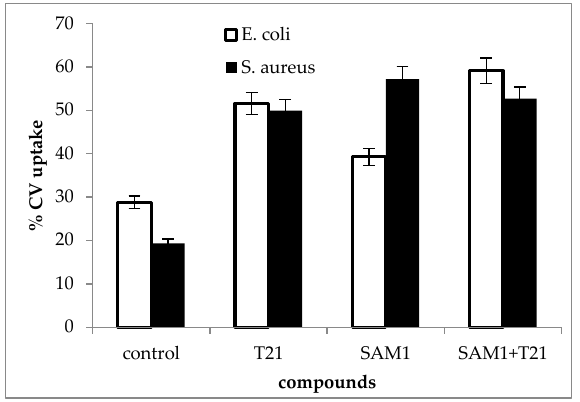
Figure 8. Crystal violet uptake in S. aureus ATCC 33952 and E. coli ATCC 11229 cultures after treatment with T21, SAM1, and SAM1 + T21 (concentration of compounds and combinations: T21 0.5%; SAM1 1MIC; SAM1 1MIC + T21 0.5%).